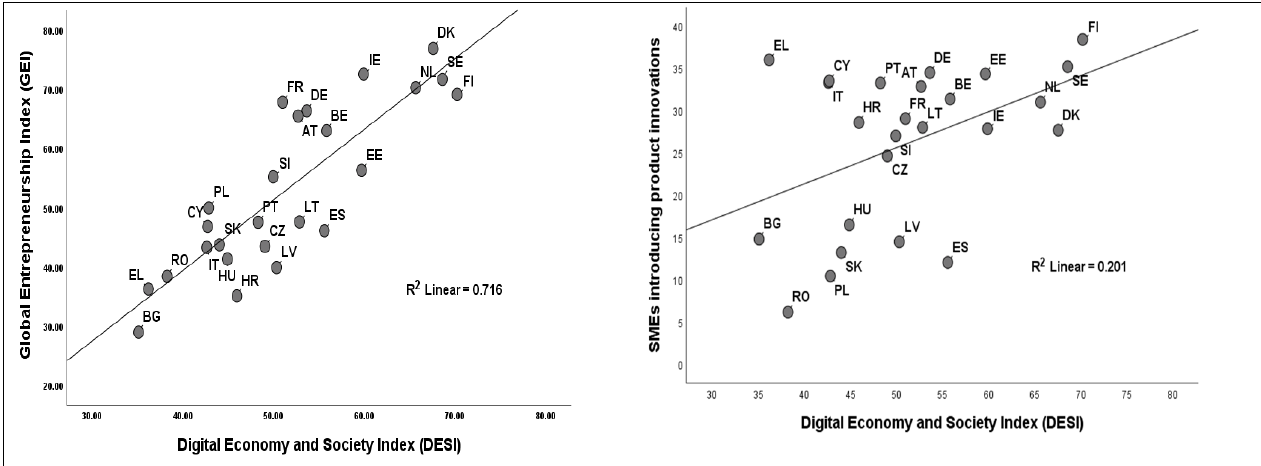
Figure 1. Positive link between productive and innovative entrepreneurship and the digitalization of an economy and society. Source: own calculations based on [59,87,89,90]. an economy and society. Source: own calculations based on